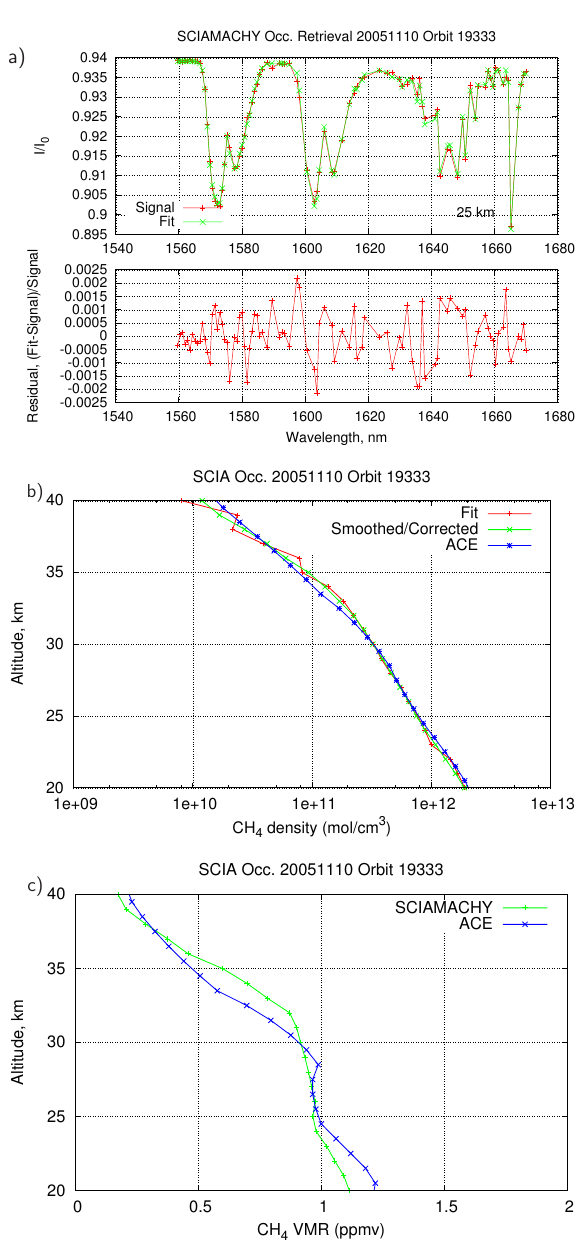
Fig. 1. Example for a CH 4 fit. (a) Measured and fitted spectra at 25km tangent altitude (top) and resulting residual (bottom). (b) Derived number density profile: uncorrected (red) and after all cor- rections (green); blue: corresponding ACE-FTS profile. (c) Corre- sponding CH 4 VMR